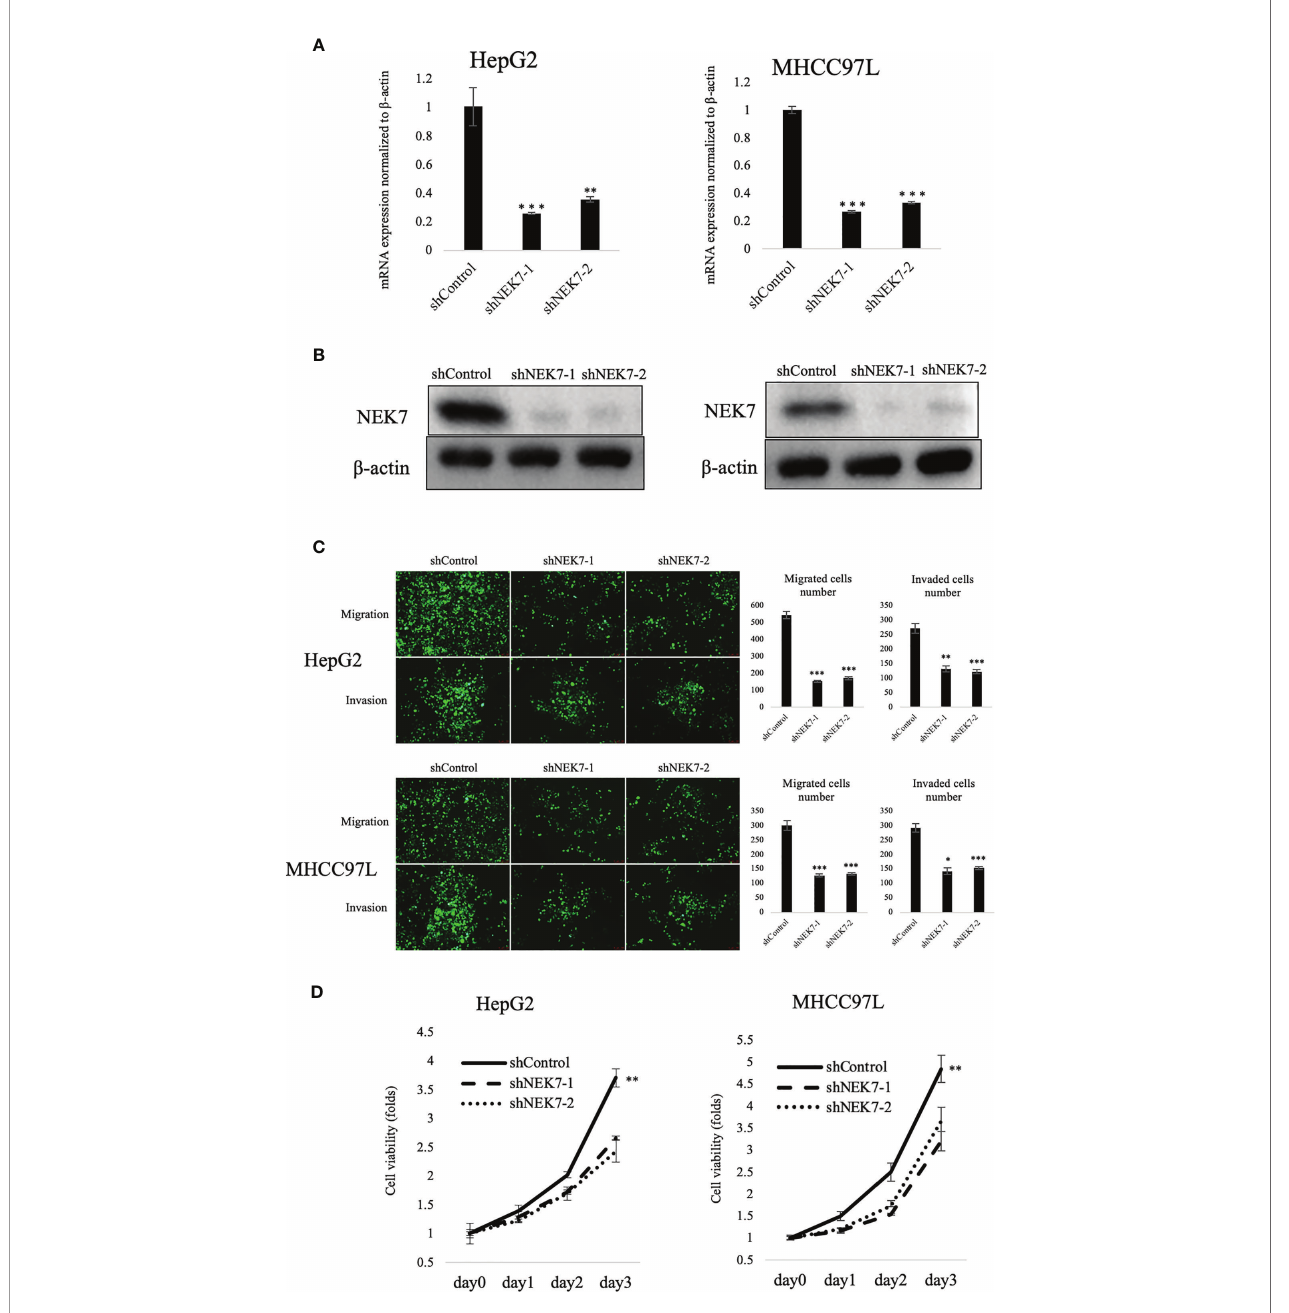
FIGURE 3 | Knockdown of NEK7 reduces migration, invasion, and cell viability of HCCs. (A, B) qRT-PCR and Western blot of NEK7 mRNA and protein levels in cells transfected with shRNAs targeting NEK7 or negative control. *** p < 0.001. (C) shControl or shNEK7 cells were dyed with CellTracker Green; migration and invasion assays were performed for 24 and 48 h. Graphs show the quanti fi cation of cells calculated from fi ve fi elds. Original magni fi cation: ×100. Scale bars = 100 m m. * p < 0.05, ** p < 0.01, *** p < 0.001. (D) Cell viability of cells was determined by CellTiter-Lumi ™ Plus cell viability assay. ** p <